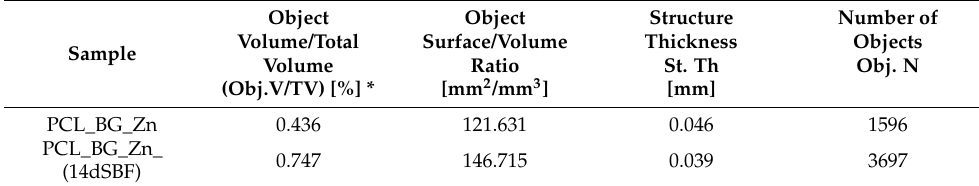
Table 5. Calculation results based on µCT images.